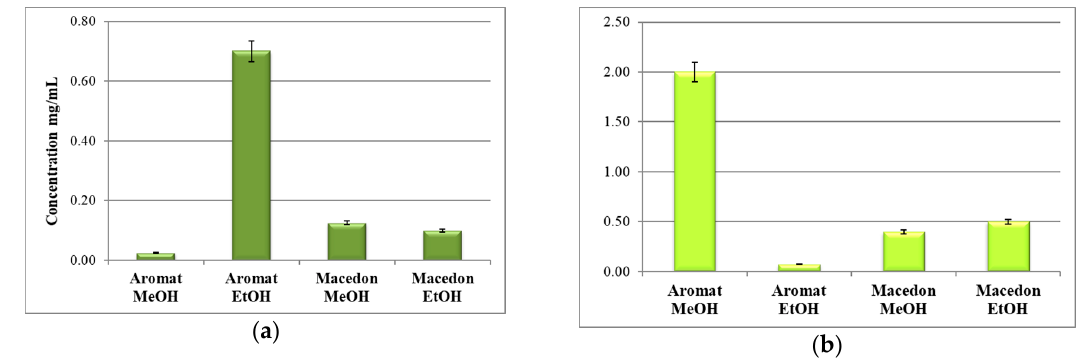
Figure 3. The DPPH inhibition percent of the ( a ) O. basilicum (”Aromat de Buzau”) methanolic extract, ( b ) O. basilicum (“Aromat de Buzau”) ethanolic extract, ( c ) O. citriodorum (“Macedon”) methanolic extract, and ( d ) O. citriodorum (“Macedon”) ethanolic extract after 20 (blue), 35 (red) and 50 (green) minutes of incubation.